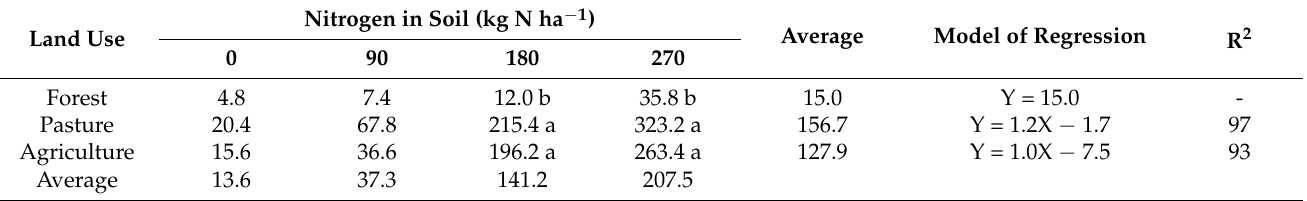
Table 3. Total N 2 O emissions ( µ g N 2 O g − 1 dry soil) in different land-use systems in the Brazilian Amazon, subjected to the addition of nitrogen in the